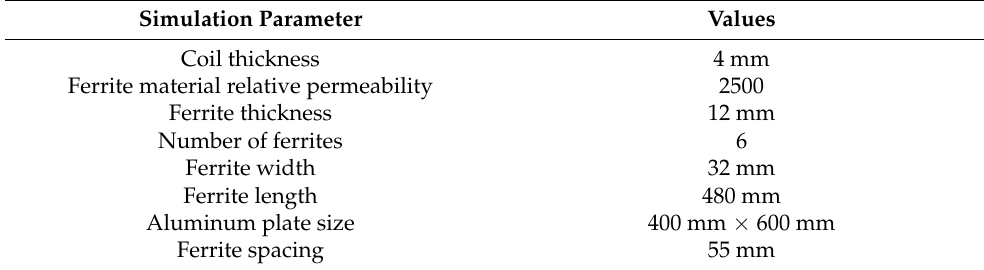
Figure 14. Key geometrical parameters of the DD structure. Table 4. Key parameters of the DD structure transformer.